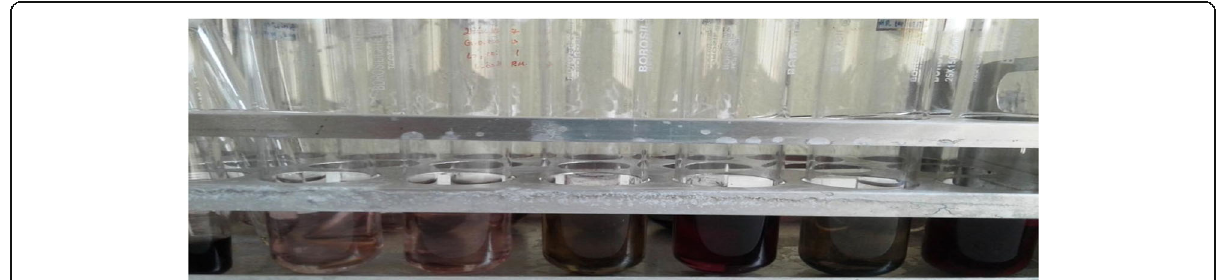
Fig. 2 The synthesized AuNPs using A. muricata peel and pulp extract